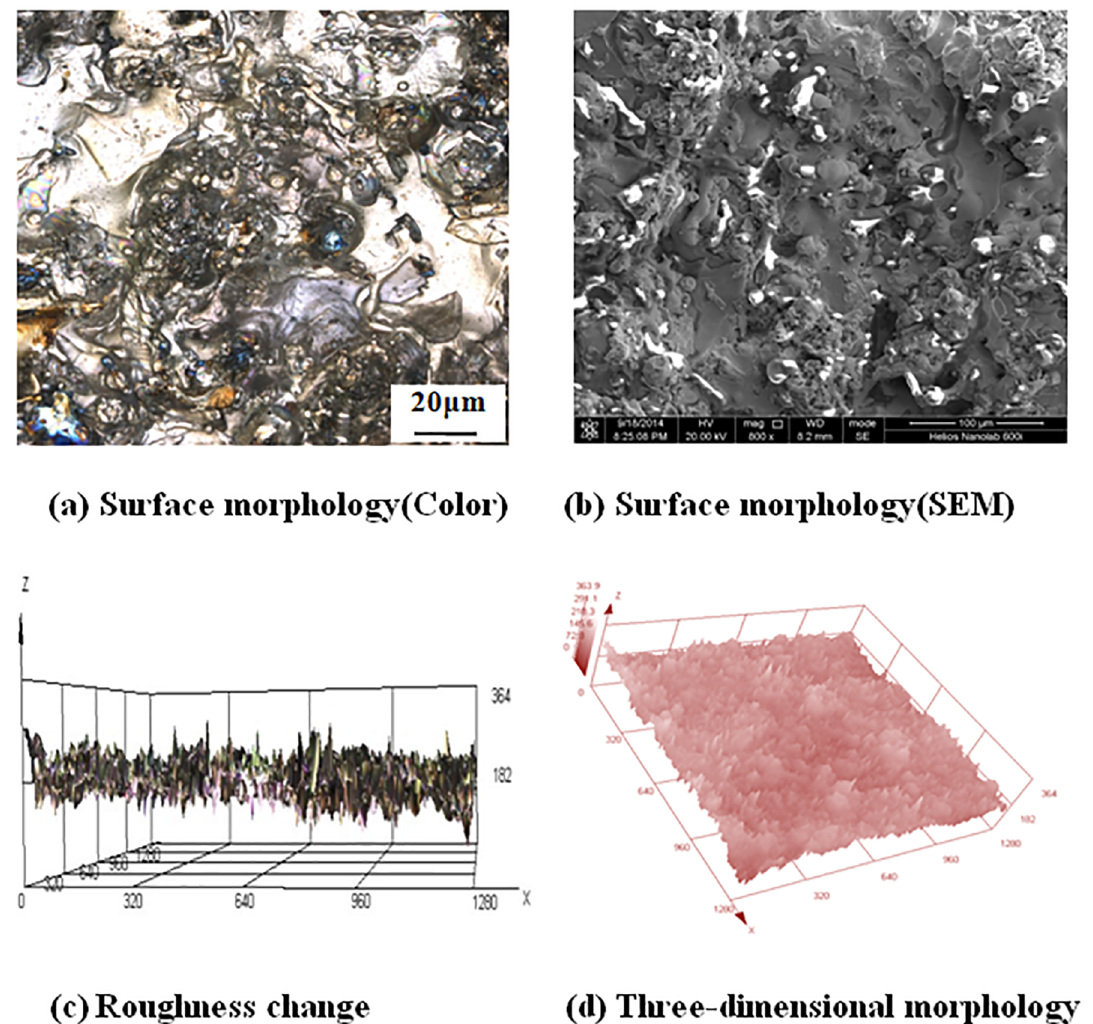
Figure 14. Surface morphology and roughness of Ni-Al coatings for (a), (b), (c) and (d).